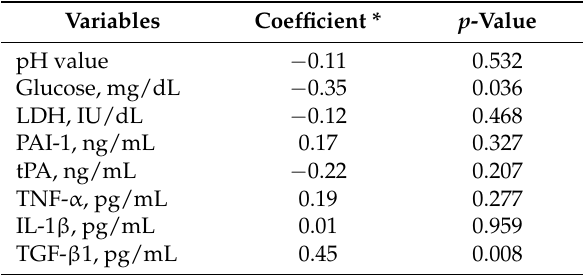
Table 3. Correlation between ET-1 and inflammatory parameters, fibrinolytic factors and cytokines in TBPE ( n = 36).